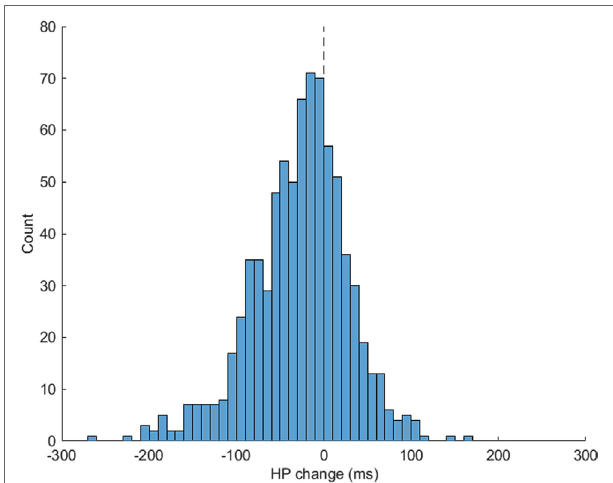
FigUre 4 | Heart period (HP) change for Soldier Performance and Effective, Adaptable Response (SPEAR) A to B task phases. SPEAR task phases A (Scenario description + Video) and B (Response prompt + Adaptability Response) respiratory sinus arrhythmia change scores are illustrated. 69.6% of the trials show a change in HP from A to B phases (number of trials below 0) indicating shifts in cardiac vagal tone to meet task demands.